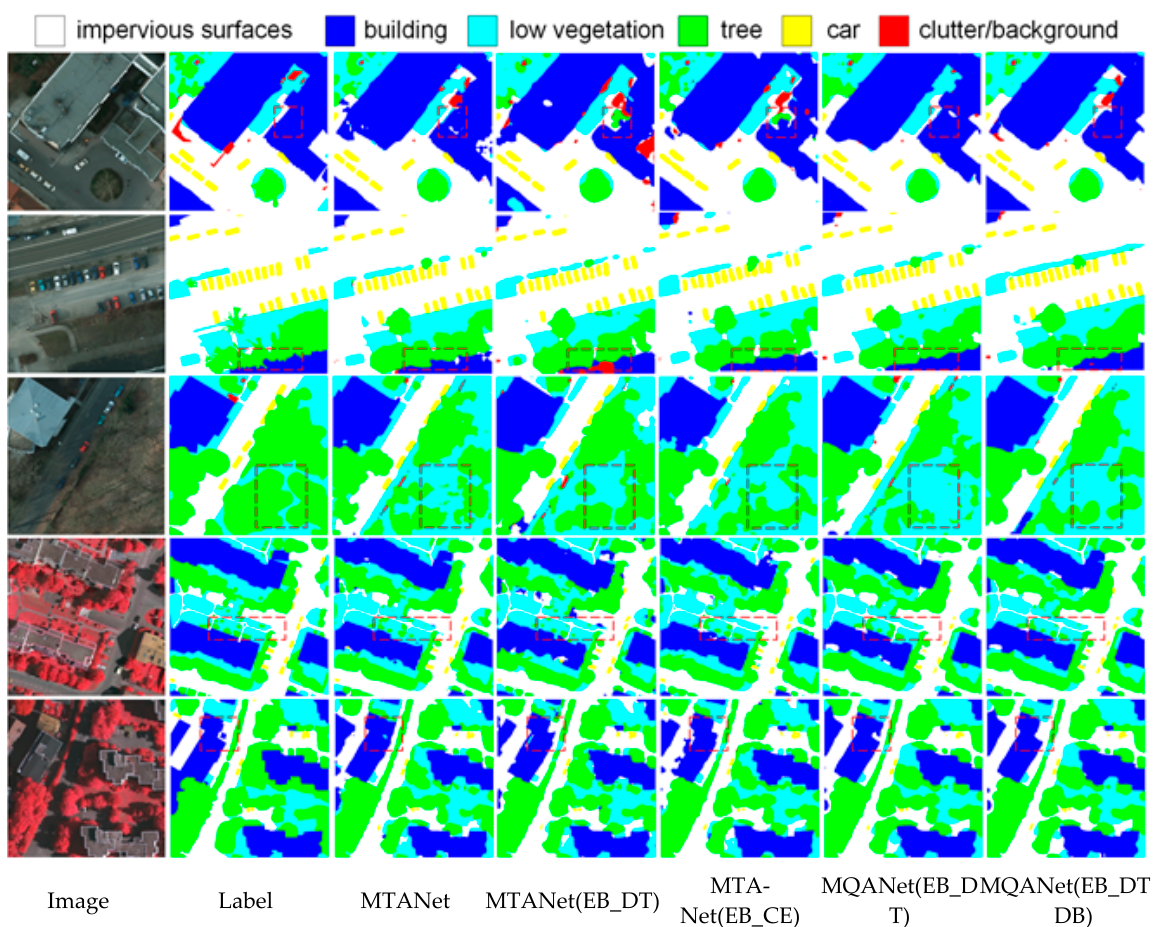
Figure 13. Results on ablation study of edge optimization. The first three rows are from the Potsdam dataset and the others are from the Vaihingen dataset.